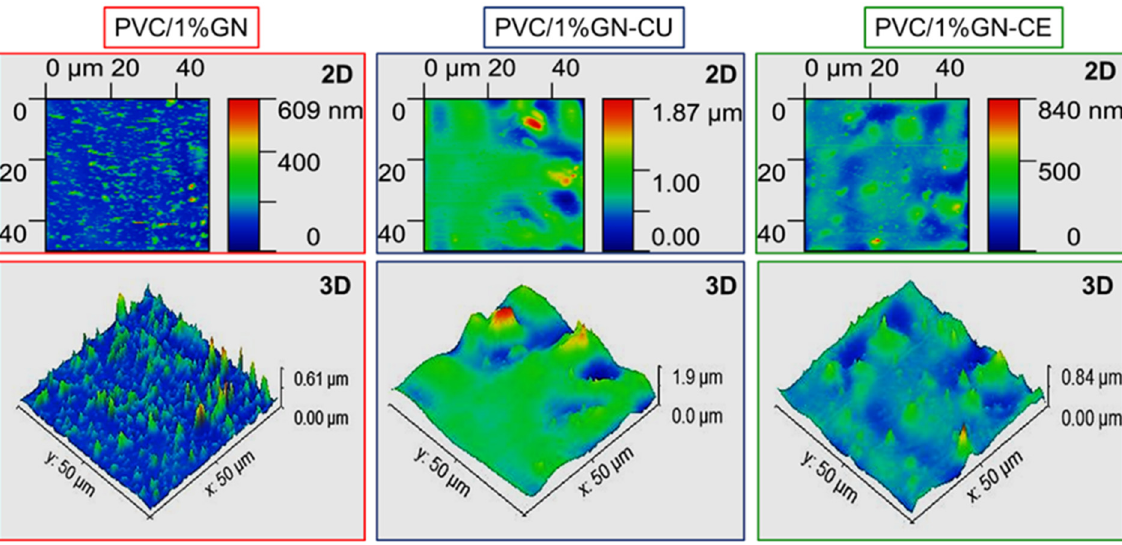
Figure 9. AFM 2D and 3D images of PVC/1% GN, PVC/1%GN–CU and PVC/1% GN–CE. The image of the surface topography of the nanocomposites shows some corrugation of the samples due to the evaporation of solvent during the formation of the polymer film [22]. AFM PVC/1%GN shows extreme inhomogeneity of the material, and the 3D image